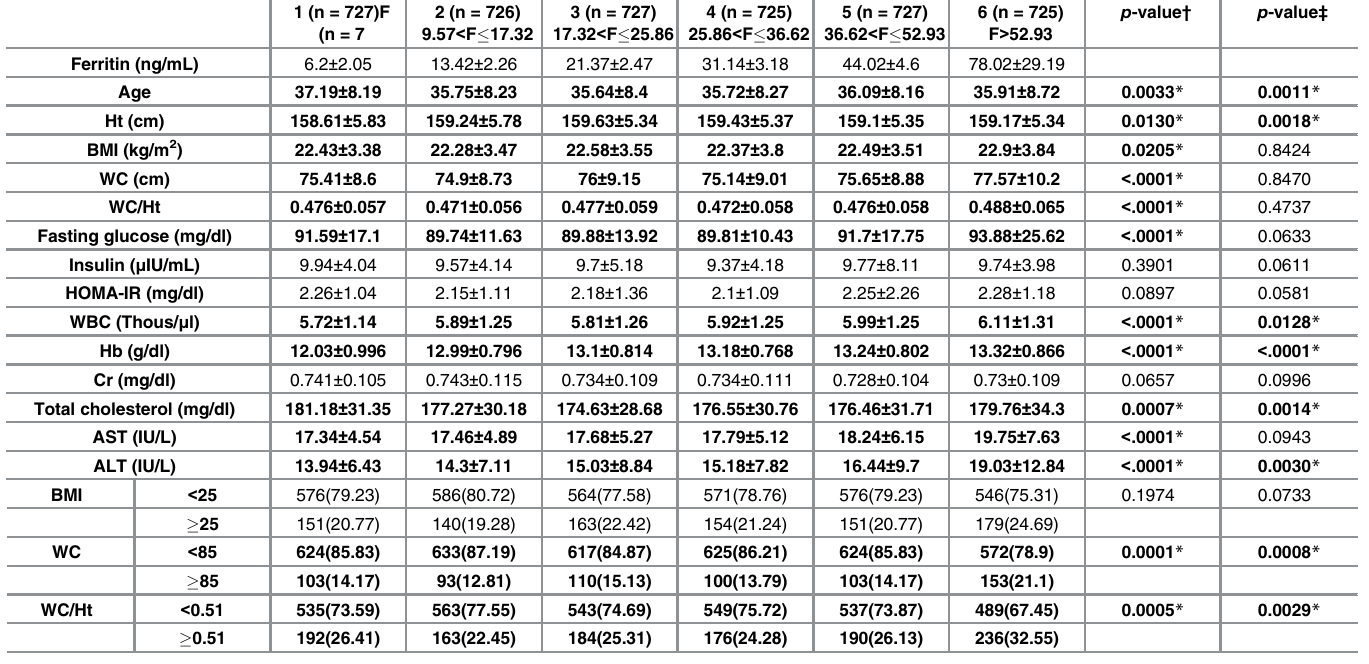
Table 1. Baseline characteristics of premenopausal women according to serum ferritin groups. 1 (n = 727)F (n =